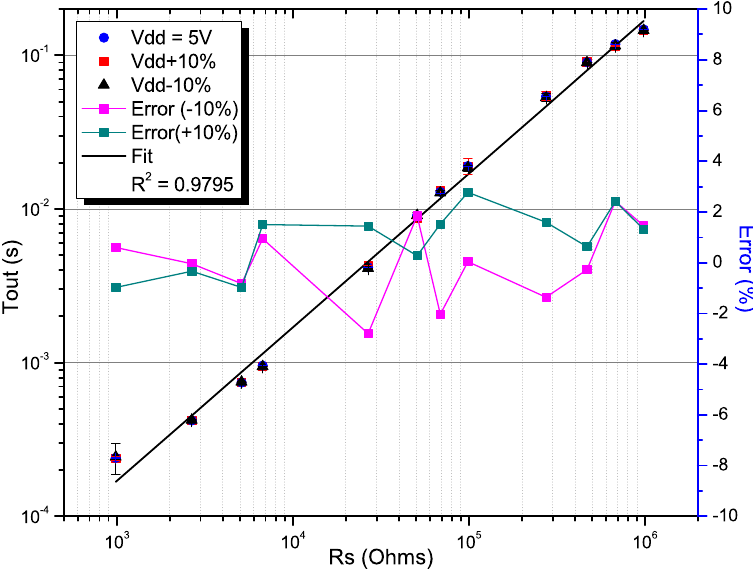
Figure 11. Period as function of the sample resistors. Experimental results with a power supply variation of ± 10% from a nominal value of 5 V.